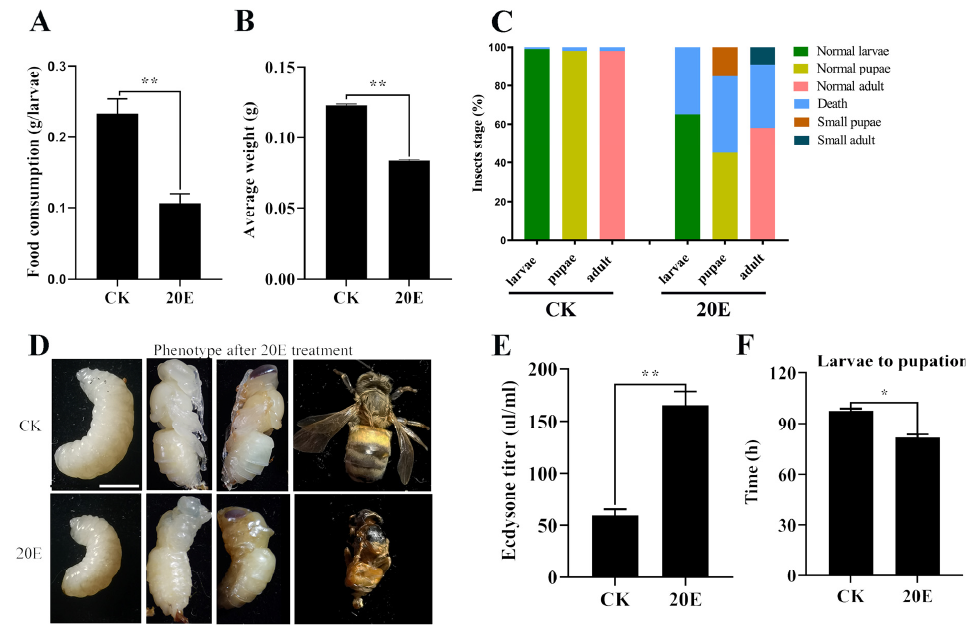
Figure 1. Effects of 20E treatment on food intake and growth. ( A ) Statistical analysis of the food consumption quantitated as the amount of diet eaten at the critical weight. Bee Ringer solution was used as the solvent control. CK as a control group. ( B ) Statistical analysis of average body weight of newly emerged worker bees; ( C ) percentage of distribution of different phenotypes in ( D ). Scale bar: 0.3 cm; ( E ) hemolymph ecdysone titer of 5d, 6d and 7d larvae; (F) Statistical analysis of the pupation time from larvae to pupation. Each point indicates the mean ecdysone concentration ± SEM. The asterisks indicate significant differences from the control group (*, p < 0.05; **, p < 0.001) by using the Student’s t- test.